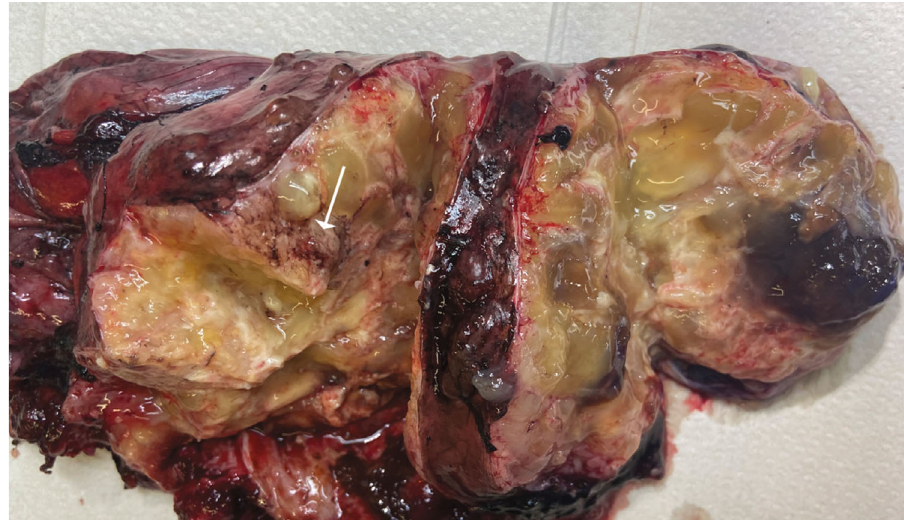
Figure 1: Macroscopic aspects of the tumor. Cystic and solid mucinous tumor with viscous content. Note the presence of solid area with osseous tissue (arrow). The capsule is